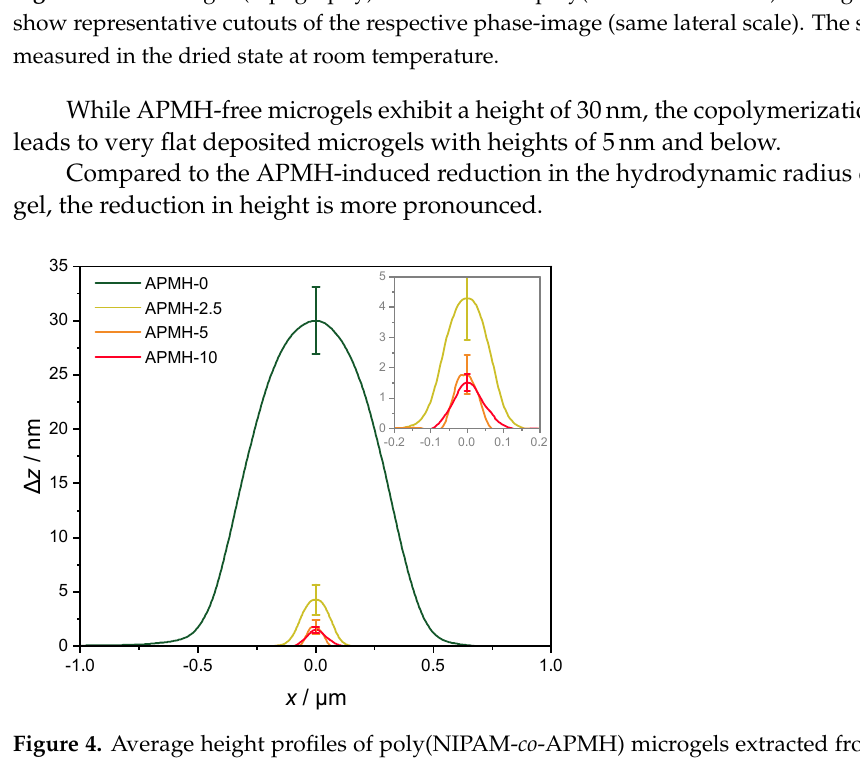
Figure 4. Average height profiles of poly(NIPAM- co -APMH) microgels extracted from topografic AFM images (Figure